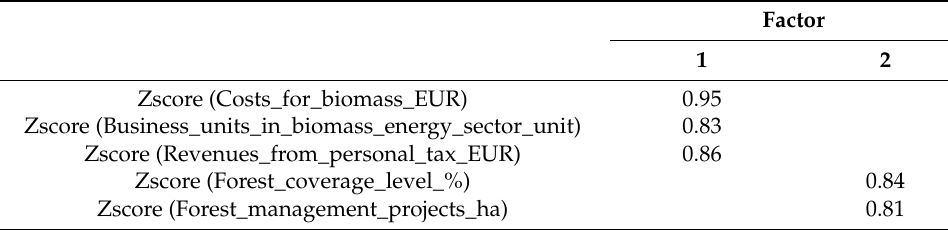
Table 5. Factor rotation analysis for biomass energy sector indicators.